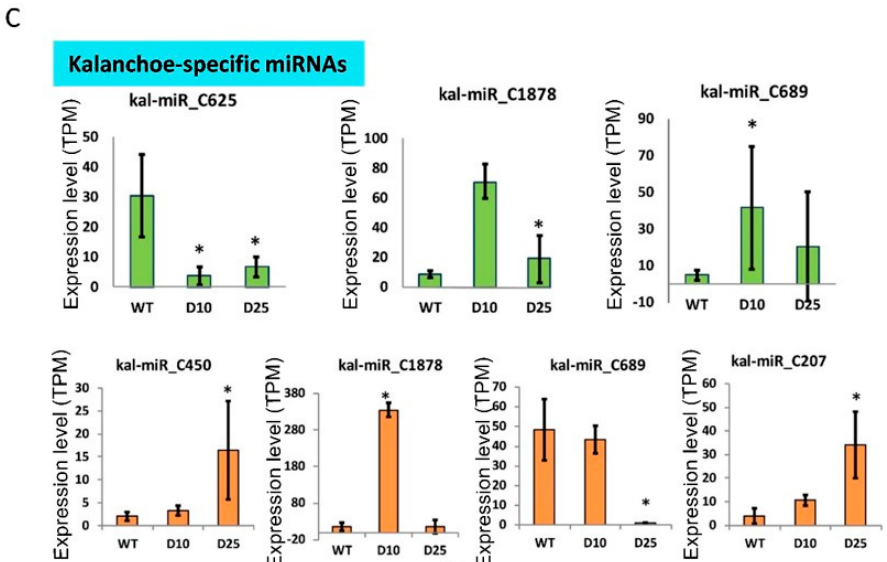
Figure 3. The differentially expressed miRNAs in epidermis and mesophyll in K. marnieriana . ( A ) Venn diagram of differentially expressed miRNA under drought conditions in epidermis (orange) and mesophyll (green). The miRNA with total TPM > 10 and 2-fold change ( p -value < 0.05) were revealed. ( B ) Venn diagram of differentially expressed miRNA in different tissues and drought conditions. ( C ) Differential expression Kalanchoë -specific miRNAs. The upper panel indicates the differential expression of miRNAs in mesophyll (green); the lower panel indicates the differential expression of miRNAs in epidermal peels (orange). * indicates significant difference ( p -value < 0.05) based on the Student’s t -test